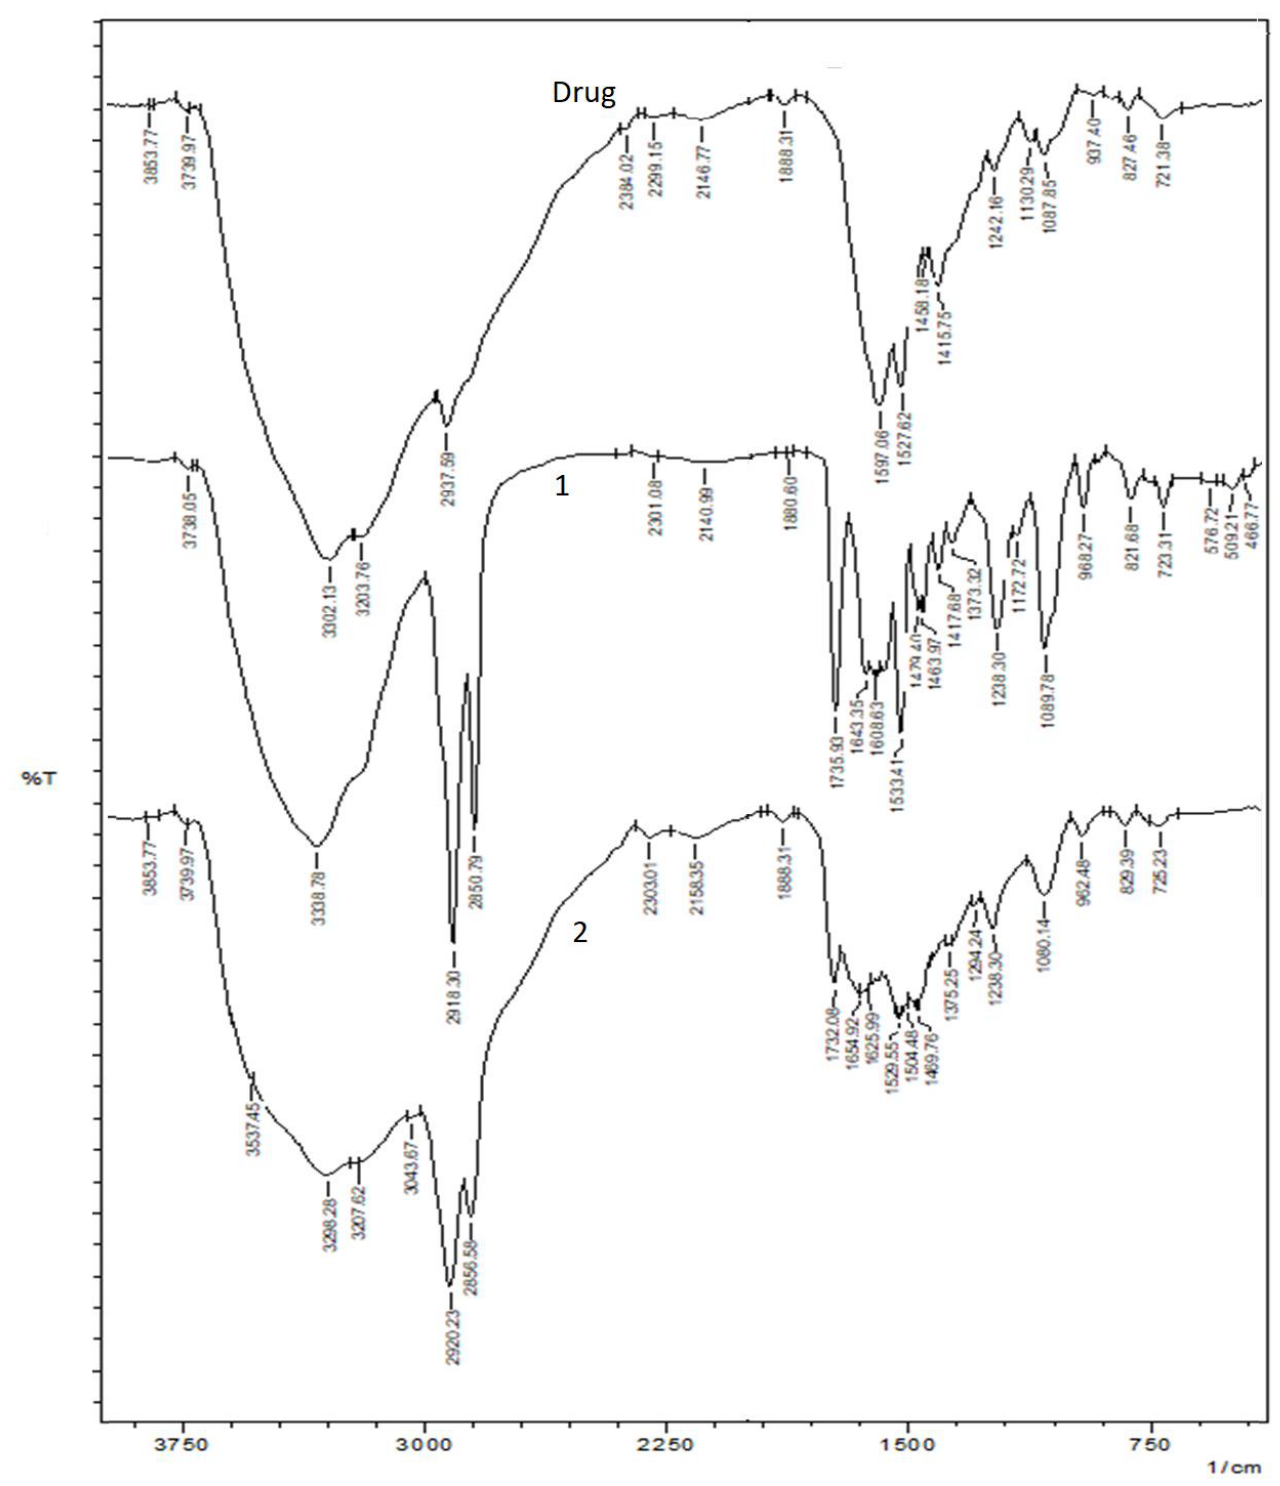
Figure 2. FTIR spectroscopic results. (Drug) Plain CHX, ( 1 ) physical mixture of CHX and excipients and, ( 2 ) CHX liposomal formulation.